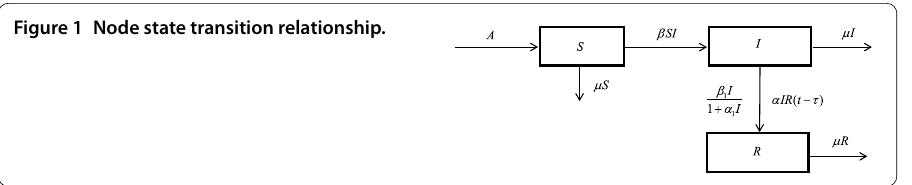
Figure 1 Node state transition